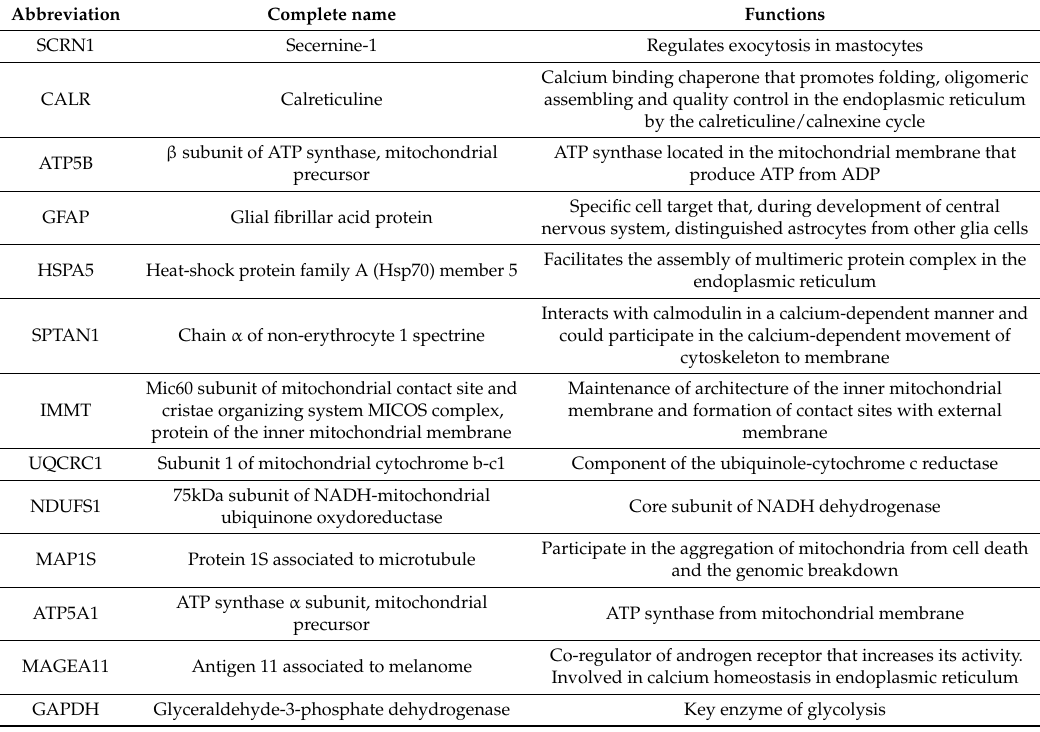
Table 2. Name and function of the brain identified